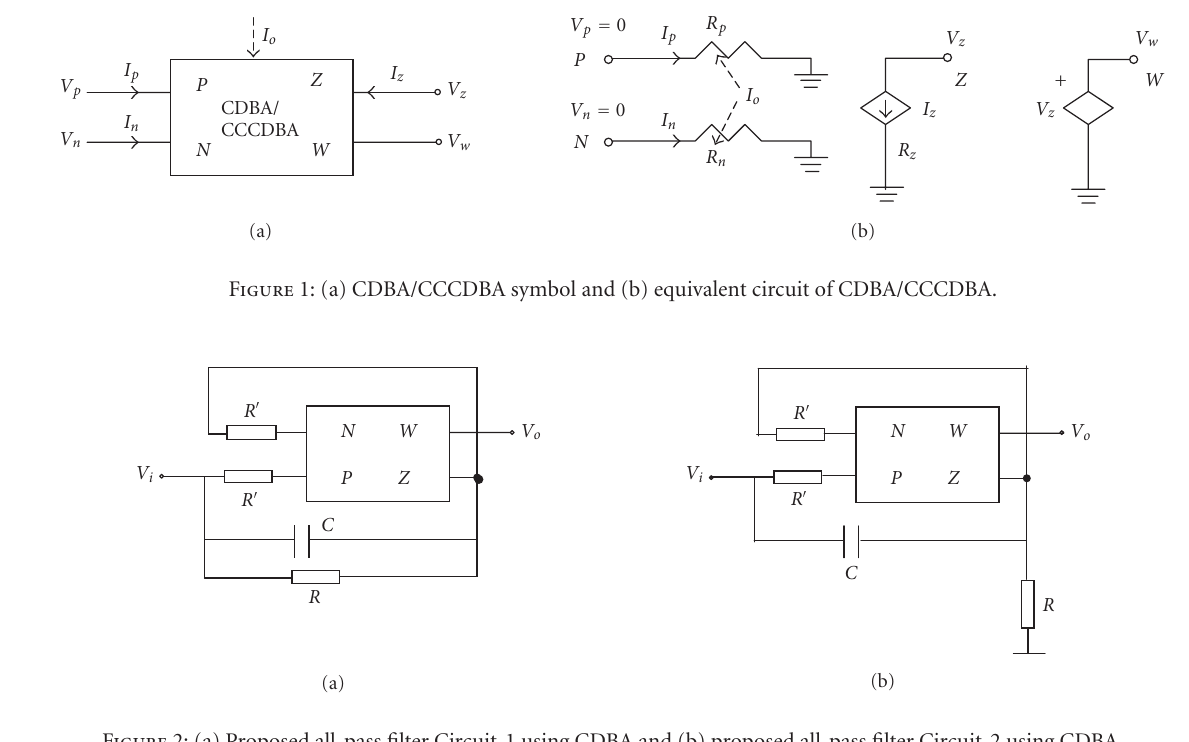
Figure 2: (a) Proposed all-pass filter Circuit-1 using CDBA and (b) proposed all-pass filter Circuit-2 using